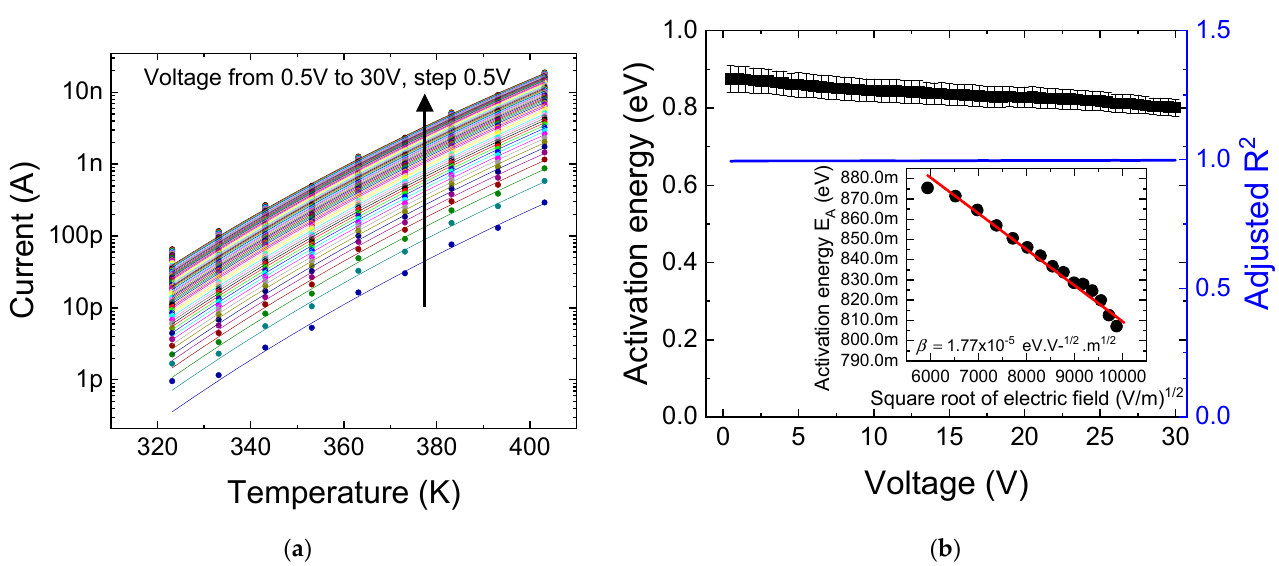
Figure 3. ( a ) Modeling reverse leakage diode behavior using Coulombic potential well model from 0 V to − 30 V (Region 1) for T = 50 °C (323 K) to 130 °C (403 K); ( b ) extrapolated trap activation energy of 0.85 eV. The R 2 of the fit is near one in the entire analyzed voltage range, confirming the good quality of the fit. (inset) Lowering in E A showing F − 1/2 dependence.